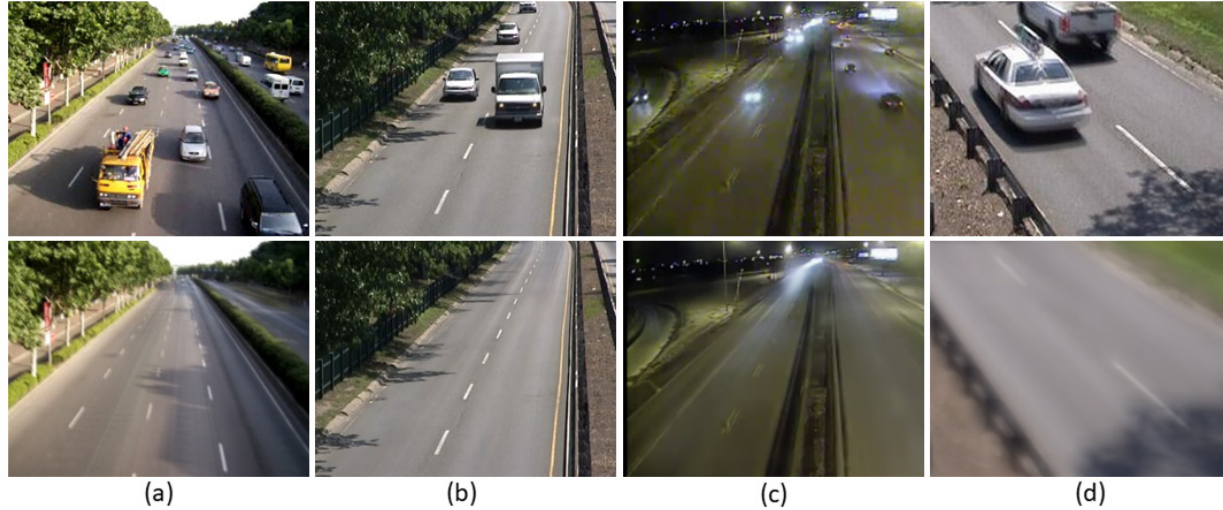
Figure 8. ( a – d ) Background modeling of four scenarios.